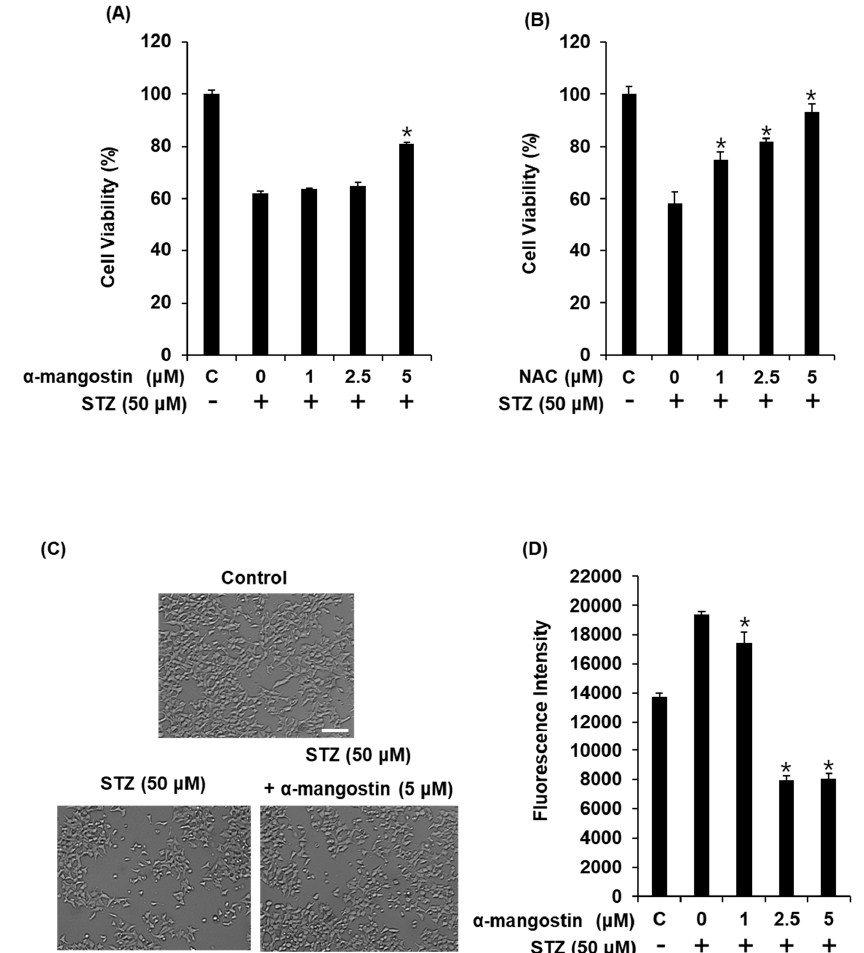
Figure 4. Effect of α -mangostin on STZ-induced damage in INS-1 cells. ( A ) Protective effect of α -mangostin against STZ-induced cell damage. ( B ) Protective effect of N -acetylcysteine (positive control) against STZ-induced cell damage. ( C ) Representative microscopic image showing the protective effects of α -mangostin on the cell morphology of INS-1 cells damaged by STZ. ( D ) Effect of α -mangostin on intracellular reactive oxygen species in INS-1 cells damaged by STZ. Scale bar = 50 µ m. * p < 0.05 compared to the STZ-treated control value.